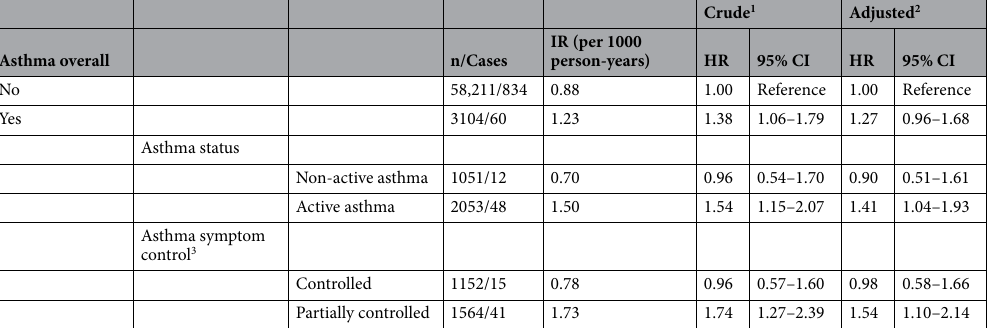
Table 3. The associations of asthma overall, asthma status and levels of asthma symptom control with lung cancer incidence after excluding the first three-year follow-up, the HUNT Study, 1995–97 to 2017 (n = 61,315). CI: Confidence interval; HR: Hazard ratio; IR: Incidence rate. 1 Age was used as the time scale in the crude model. 2 Adjusted for sex, body mass index, smoking [(never, former (< 10, 10–20, and > 20 pack-years (pyrs)), current (< 10, 10–20, and > 20 pyrs)], passive smoking, alcohol consumption, physical activity, total sitting time daily, education, economic difficulties, family history of cancer and allergic rhinitis. Age was used as the time scale. Tvc option of the stcox command in Stata was used to model the non-proportional hazards for sex, smoking and economic difficulties in the adjusted models. 3 An “unknown” level of asthma symptom control with limited lung cancer cases (n = 4) is not